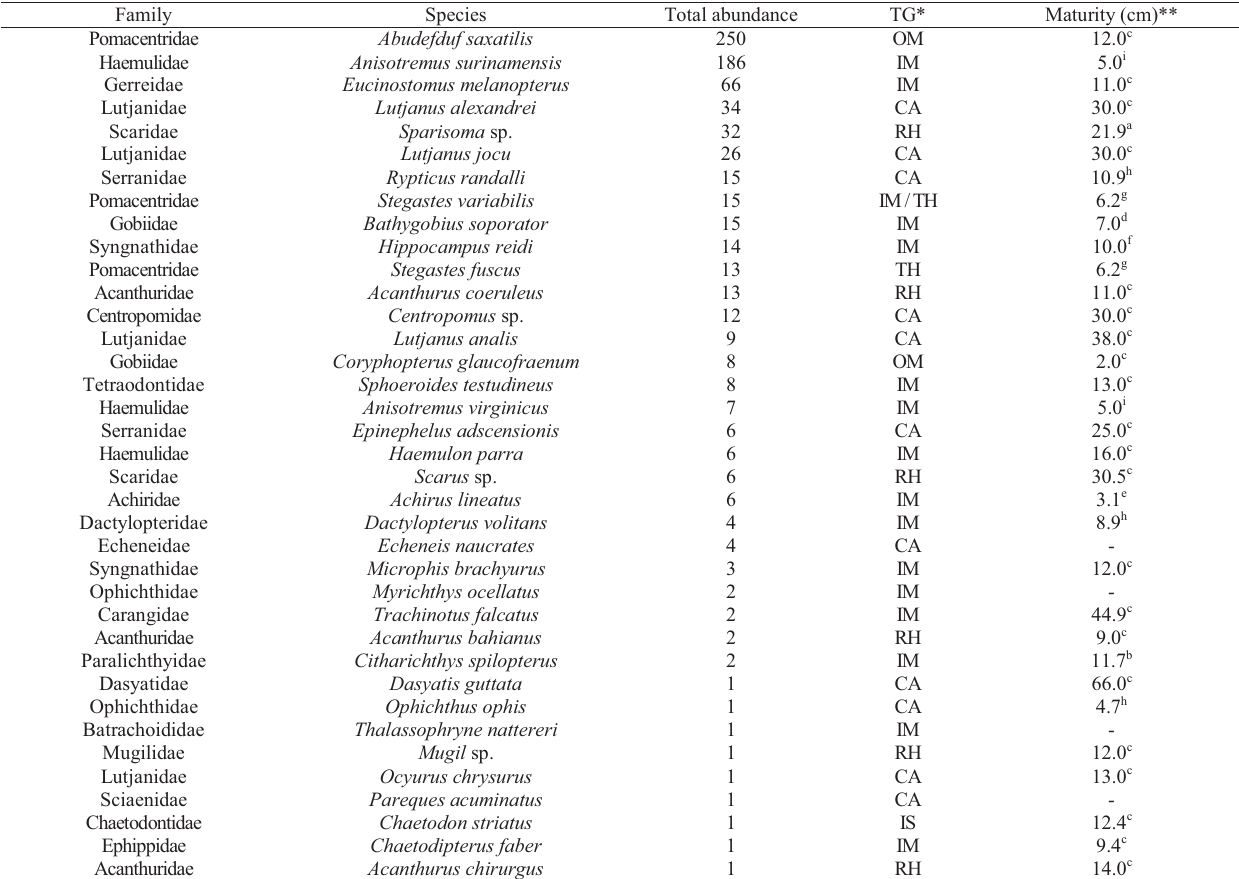
Table 2. Information on family and species, total abundance, trophic group, and maturity size of fishes sighted in the Mamanguape estuary, State of Paraíba, NE Brazil, from October 2007 to September 2008. * Trophic group (TG): CA - carnivore; IM - invertivore of mobile prey; IS - invertivore of sessile prey; RH - roving herbivore; TH - territorial herbivore; OM - omnivore. ** When size at first maturity was not available for the sighted species, it was inferred from other species from the same genus, which were Abudefduf vaigiensis , Anisotremus davidsonii , Centropomus undecimalis , Eucinostomus gula , Haemulon plumierii , Mugil curema , Ophichthus gomesii , Scarus coeruleus , and Stegastes variabilis . Size at maturity